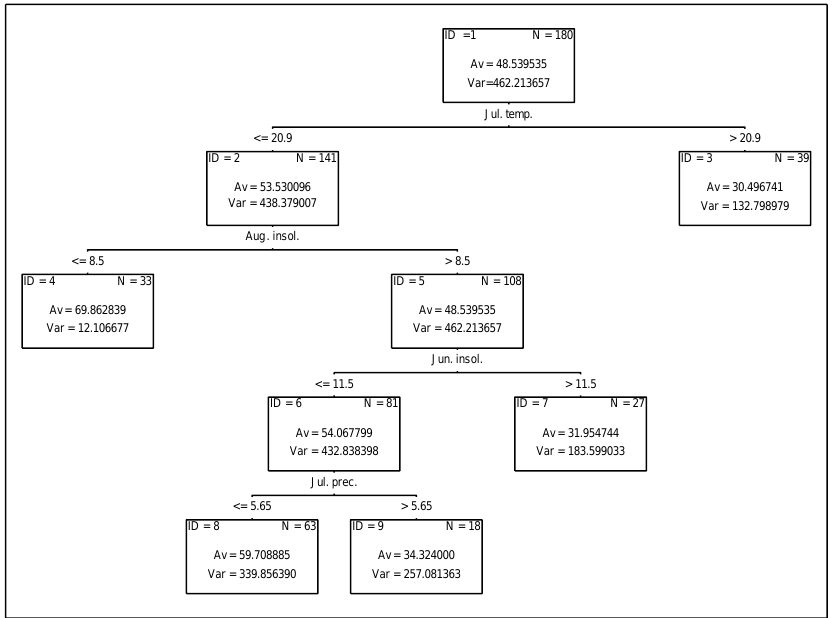
Figure 6. Diagram of regression tree reflecting nitrogen acquisition from the atmosphere by soybean plants treated with Improver. 3.3. Analysis of the Effect of Meteorologial Conditions on Nitrogen Uptake from Fertiliser Regression trees describing the amount of nitrogen taken up by soybeans from ferti- liser consisted of four terminal nodes. Both in the control unit and plots treated with bi- ostimulants, the amount of nitrogen taken up from fertiliser was predominantly affected by temperatures in July and June, and precipitation in July. When the temperature in July exceeded 20.9 °C, fertiliser nitrogen uptake by soybean plants was the lowest and ranged from 7.71 (no biostimulant) to 9.35 kg (treatment with Improver), it being the highest (from 10.64 to 14.98 kg) when the temperatures in July and June did not exceed 20.9 and 13.15 °C, respectively, and daily precipitation sums in July were up to 5.65 mm (Figures 7 – 9). Research by LeMenza et al. [49] has shown that, when grown under conditions which allow soybean to produce yields higher than 2.5 Mg ha −1 , the crop may positively respond to nitrogen fertilisation. Unfortunately, a high concentration of mineral nitrogen forms in soil tends to inhibit elemental nitrogen reduction conducted by nodulating bac- teria by hampering the activity of enzymes which are involved in this process, and the development of root nodules. Furthermore, research by Salvagiotti et al. [50] has demon- strated that mineral nitrogen has a negative effect on nodulation and N 2 fixation by soy- beans, excluding nitrogen starter fertiliser applied during sowing.